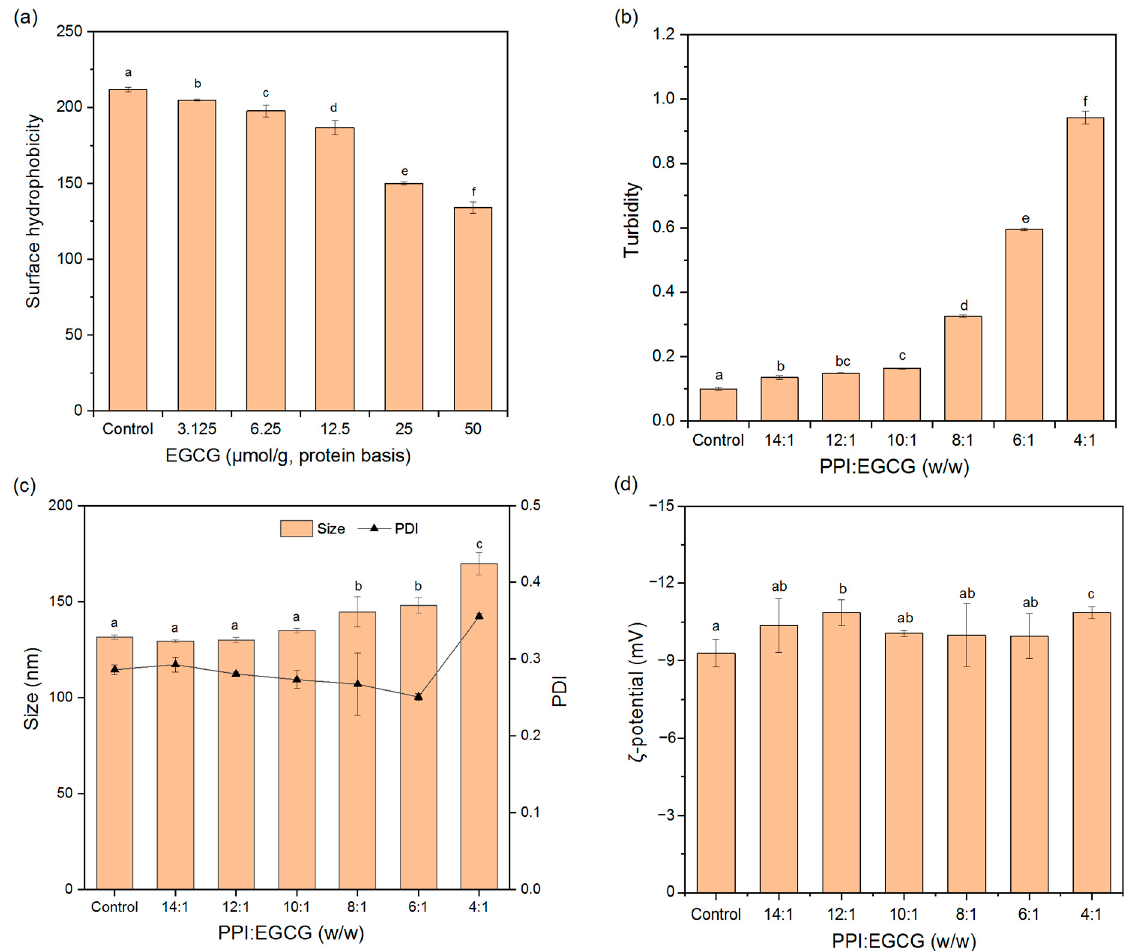
Figure 8. Surface hydrophobicity ( a ), turbidity ( b ), particle size ( c ) and zeta-potential ( d ) of PPI and PPI-EGCG complexes. The different letters represent the fact that the difference is significant ( p < 0.05).